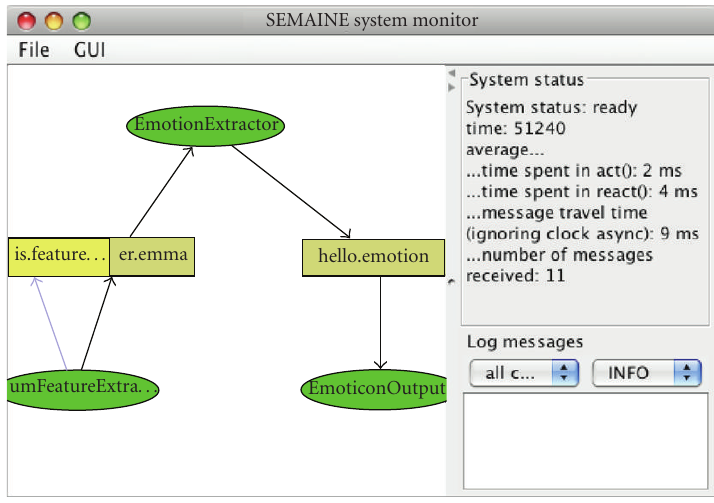
Figure 18: Message flow graph of the Emotion mirror system.